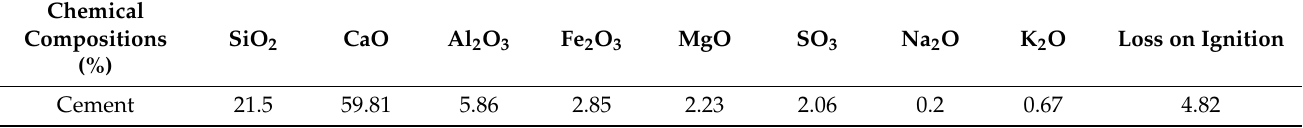
Table 2. Chemical compositions of cement.